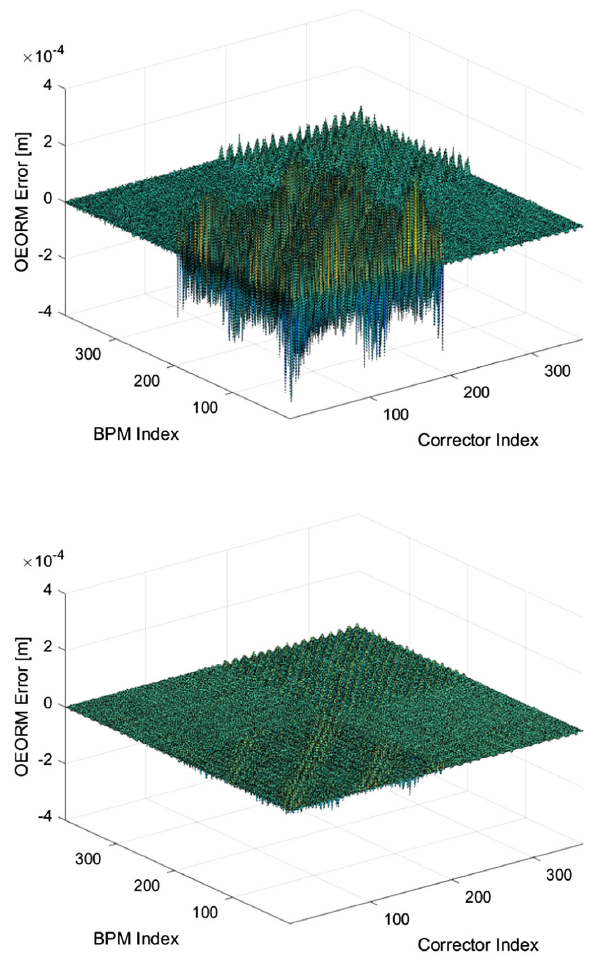
FIG. 14. Difference between measured and nominal OEORM before (top) and after (bottom) applying the sextupole symmet- rization to